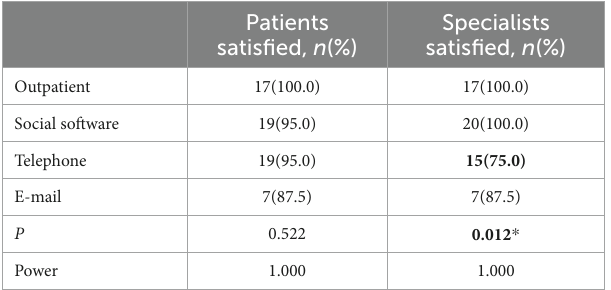
those within or between groups, with or without statistical